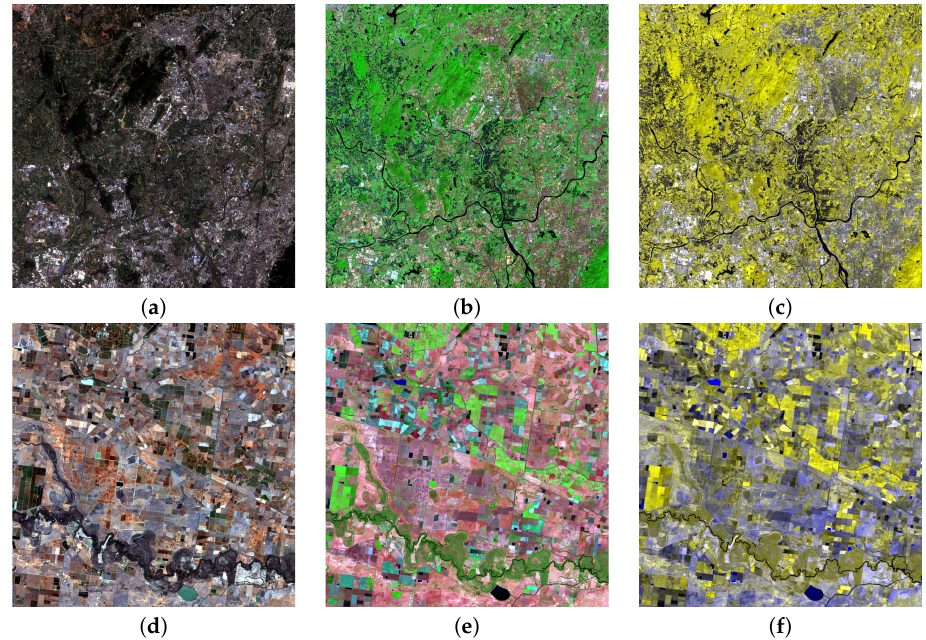
Figure 3. The training dataset used in the experiments. ( a ) The 10 m bands (7200 B3, B2 as RGB). ( b ) The 20 m bands (3600 (1200 1200 pixels, B9, B9, B1 as RGB). ×